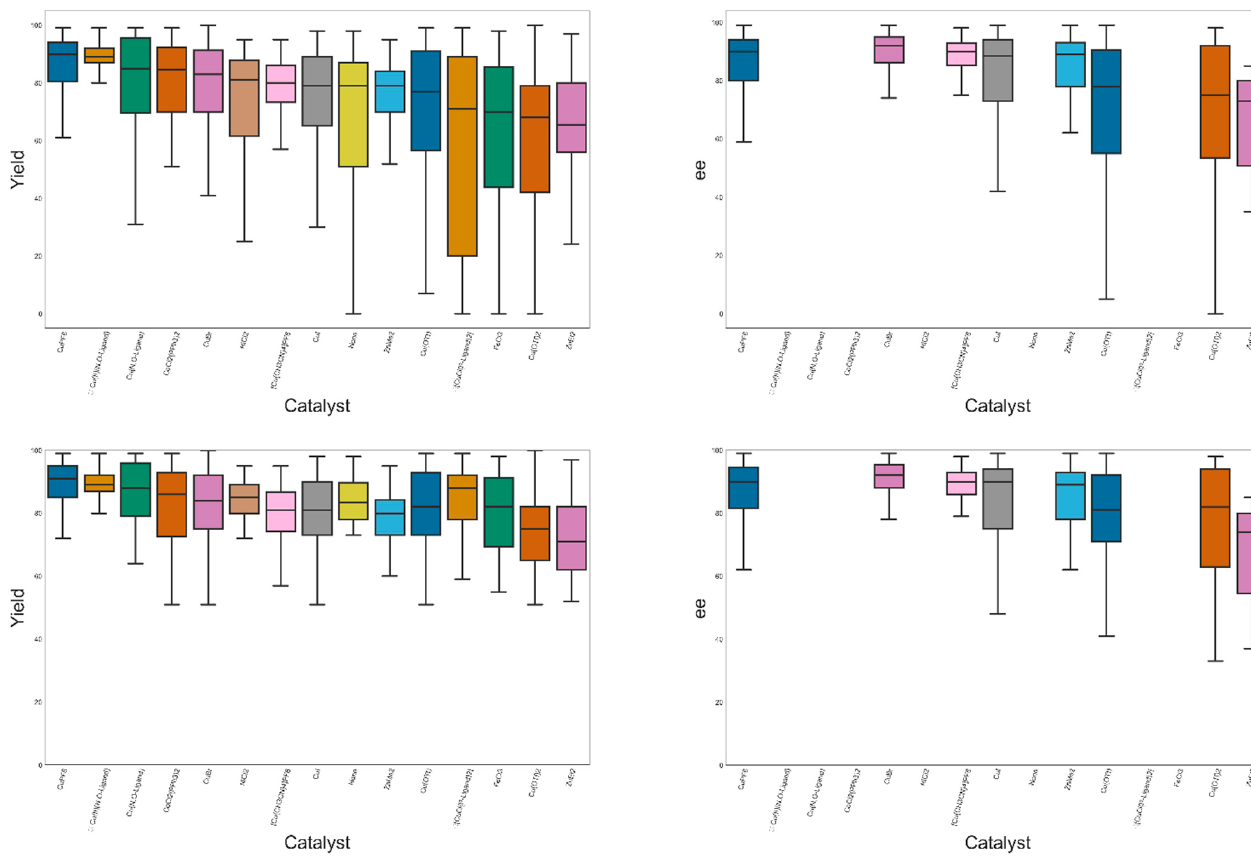
Figure 8. ( upper ) Yields ( left ) and ee ( right ) of different metal salts with more than 50 entries. ( lower ) Yields ( left ) and ee ( right ) of different metal salts with more than 50 entries and yield greater than 50%.